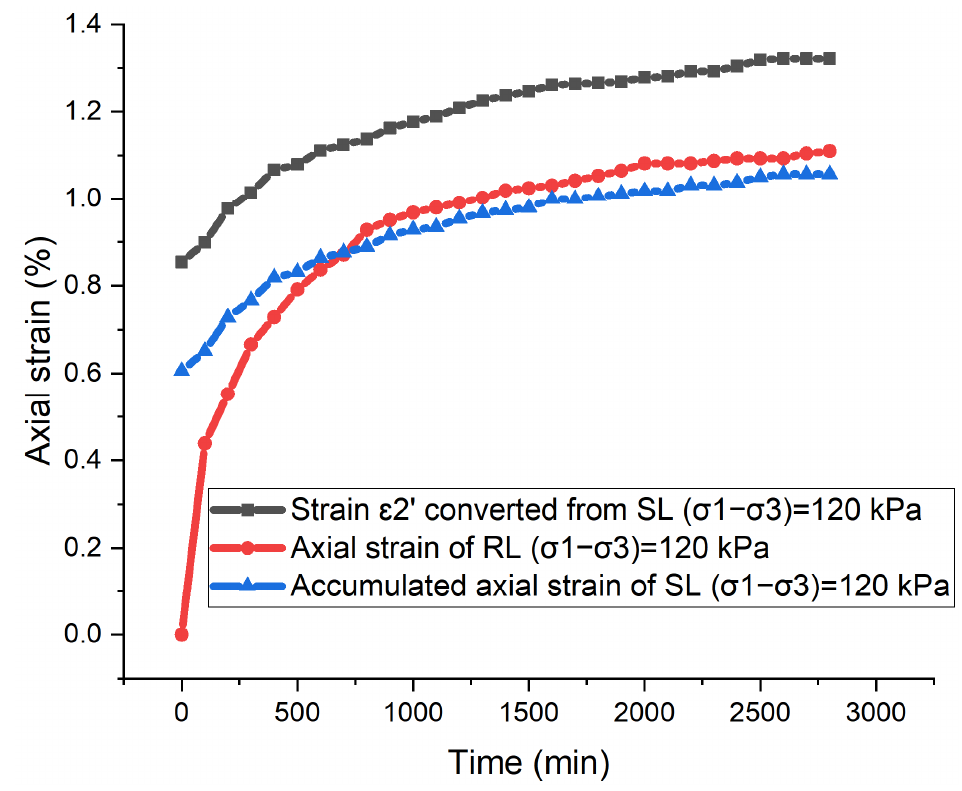
Figure 5. Comparison of converted RL axial deformation and tested RL and SL axial deformation when (σ − σ ) = 120kPa (Test 4, 2).